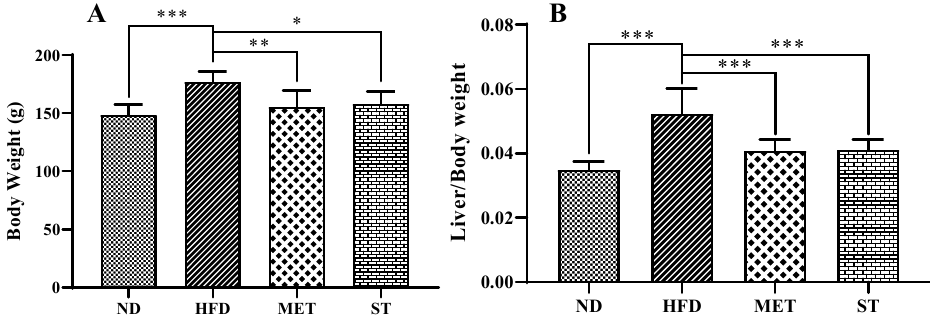
Figure 2. Effects of methanol extract of fermented green tea and spore suspension on body weight of hamsters for 2 consecutive weeks. ( A ): body weight; ( B ): ratio of liver weight to body weight. ND: normal diet treated group; HFD: high-fat diet; MET: high-fat diet with methanol extract of fermented green tea intervention group; ST: high-fat diet with the spore intervention group. Data are expressed as mean ± SD ( n = 10). * p ≤ 0.05; ** p ≤ 0.01; and *** p ≤ 0.001.